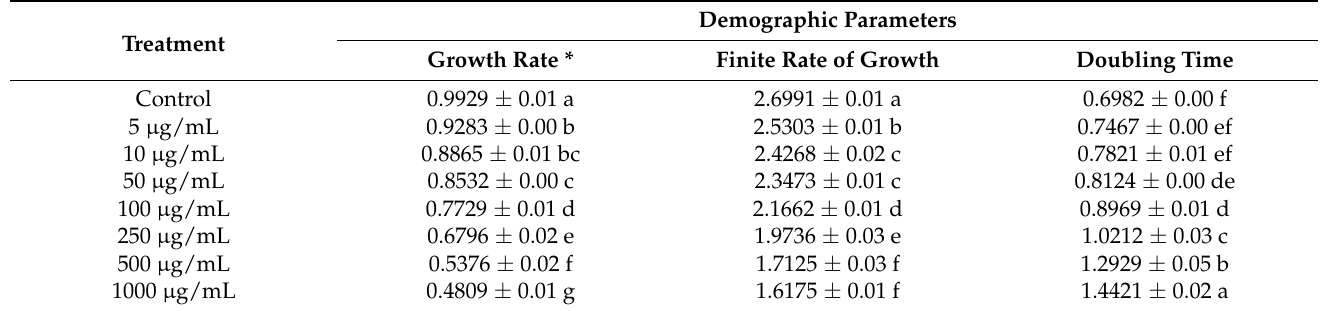
Table 4. Effects of Magnolia tamaulipana leaf ethanolic powdered extract on the rate of increase, the finite rate of increase, and the population doubling time of Oligonychus punicae .